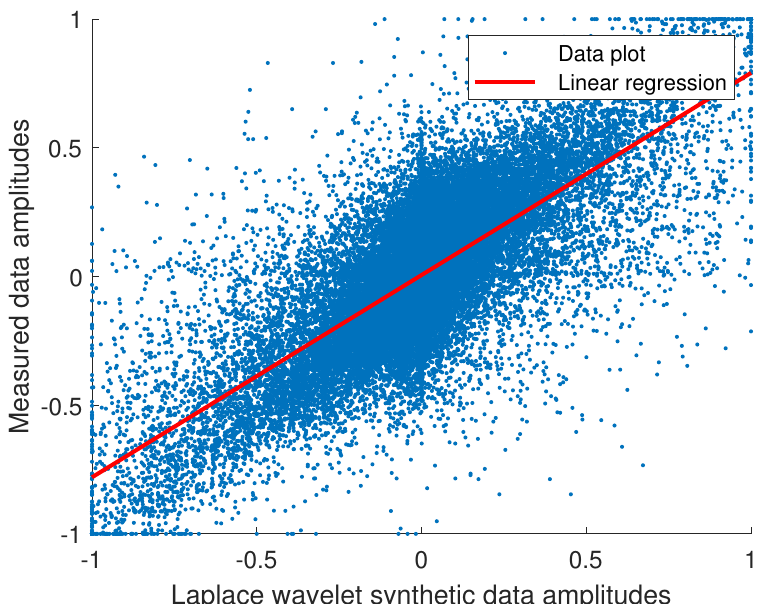
Figure 14. Data fit of real vs. synthetic data processed with the Laplace Wavelet technique calculating one mode at a